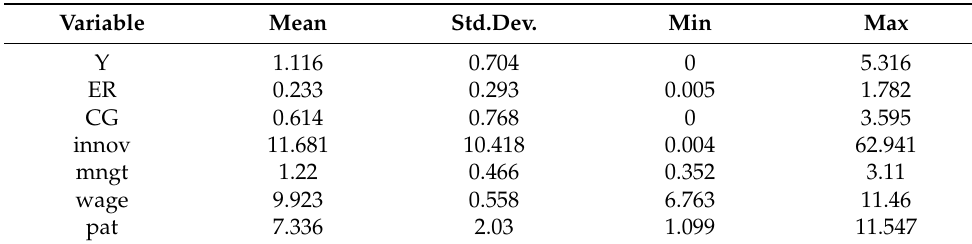
Table 1. Descriptive statistics.